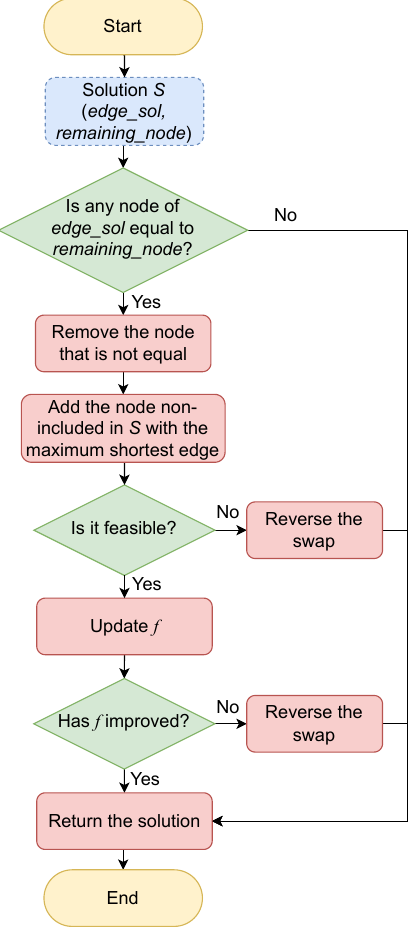
Figure 2. Last move of the destructive